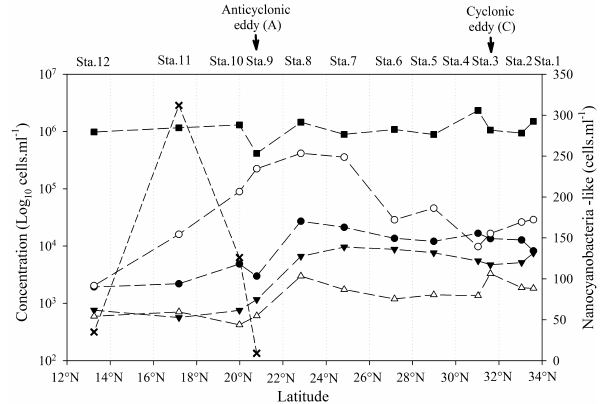
Fig. 8. Abundances of heterotrophic prokaryotes and ultraphyto- plankton at surface depending on the latitude along the 141.5 ◦ E meridian. The sampling stations are given on the upper scale axis. The black squares represent the concentration of the heterotrophic prokaryotes, the white circles the Prochlorococcus , the black cir- cles the Synechococcus , the black and the white triangles the abundances of picoeukaryotes and nanoeukaryotes, respectively. The black crosses show the nanocyanobacteria-like (right axis). Nanocyanobacteria-like were not detected in the surface samples from the stations 1 to